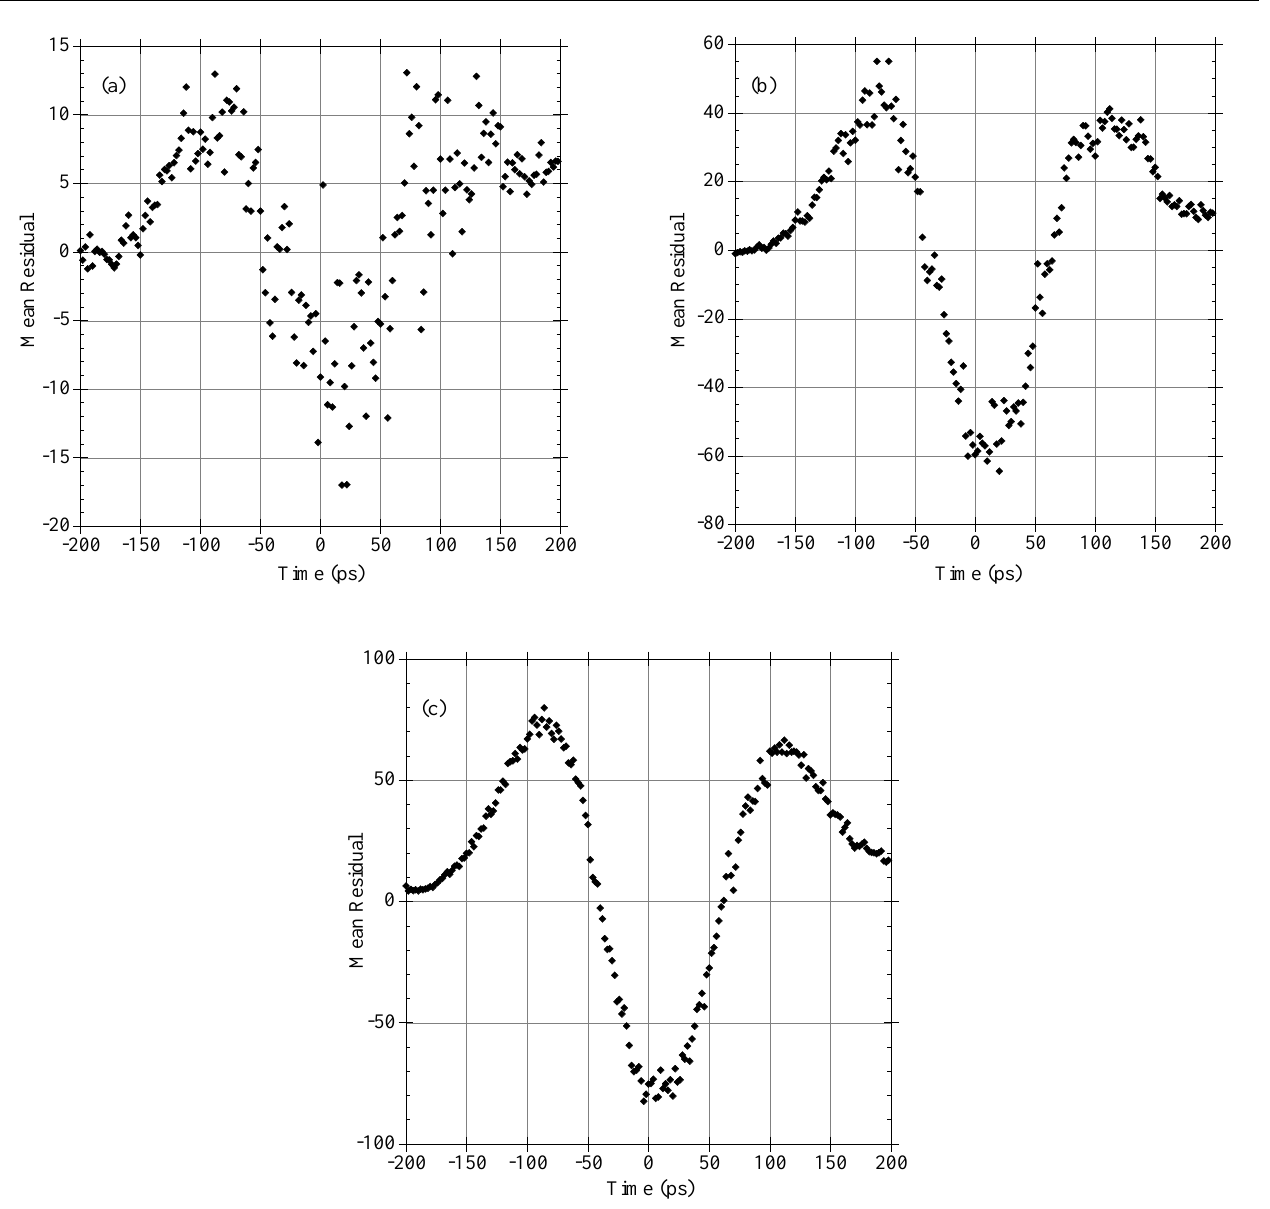
FIG. 17. The mean residual when the amplitude of the rf voltage is modulated at voltage amplitudes of (a) 0 dBm, (b) 1 5 dBm, and (c) 1 10 dBm and frequency of 349.9 kHz.